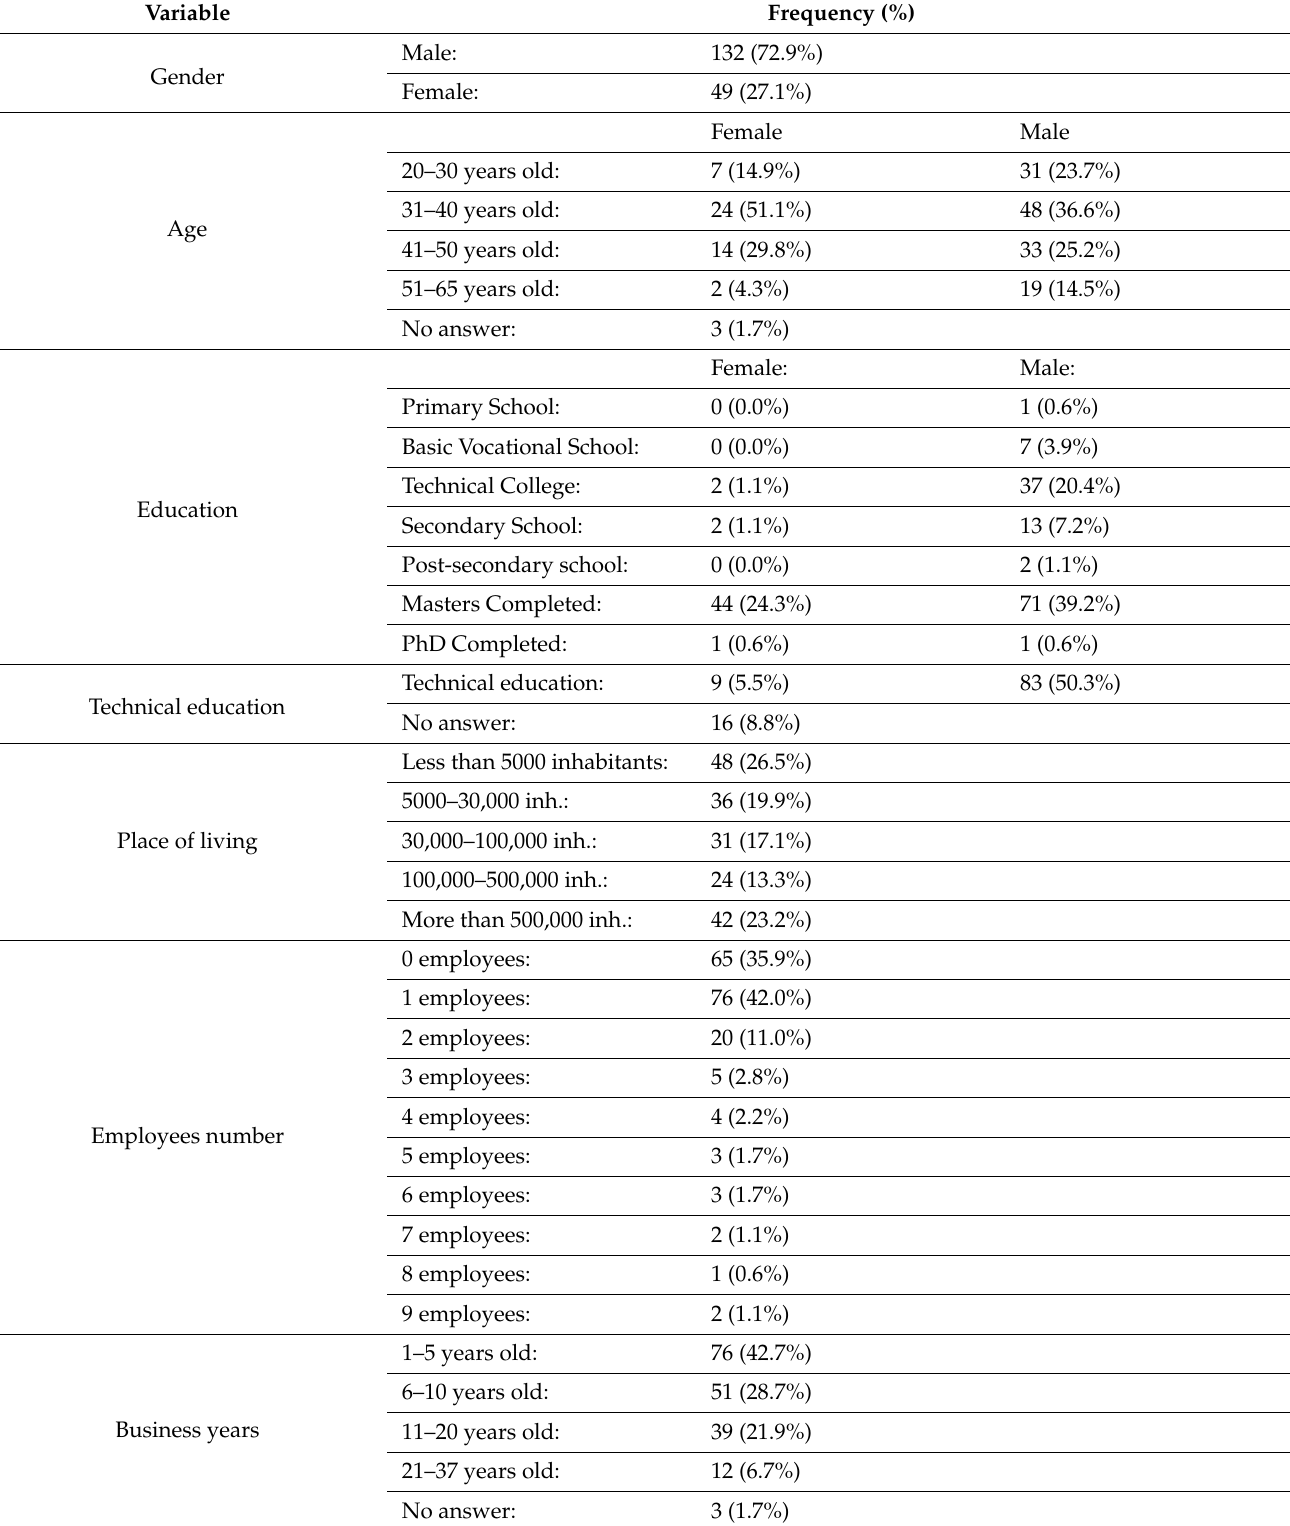
Table 1. Demographic and economic variables microenterprises that took part in the study (N = 181).